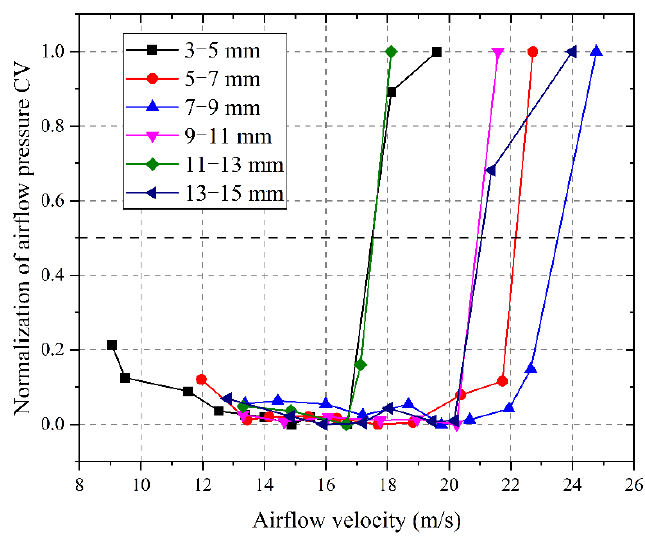
Figure 12. Relationship between coefficient of difference and airflow velocity.